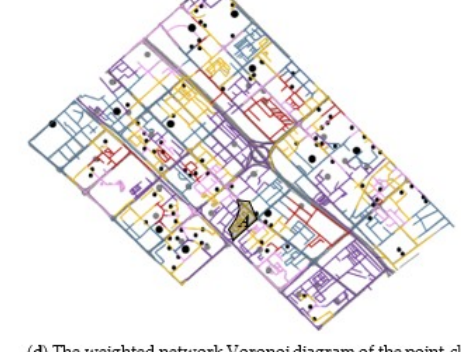
Figure 9. The generation of the weighted network Voronoi diagram of points in the study area.